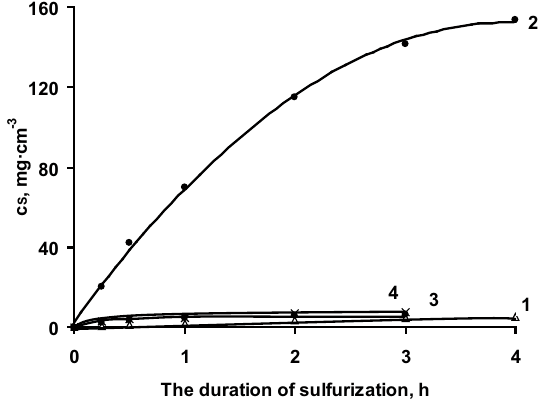
Figure 1. Changes of sulfur concentration in the films of PA (curves 1